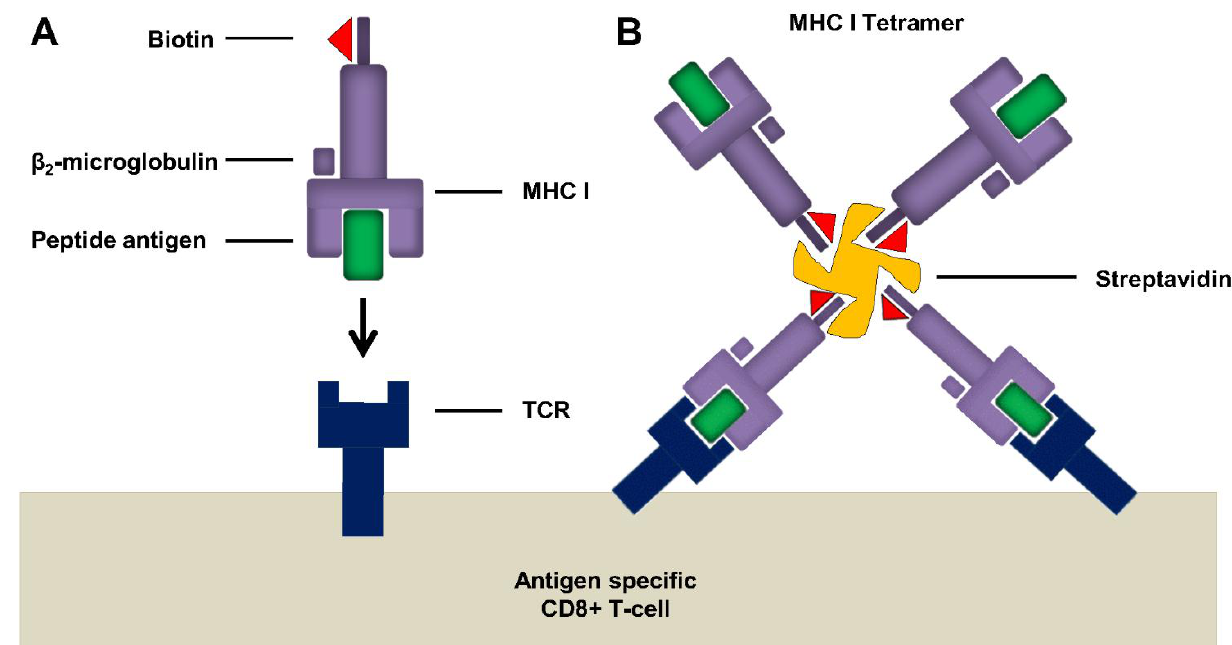
Figure 2. Tetramers increase avidity for epitope specific TCR interactions. ( A ) Schematic showing the recognition of peptide loaded biotinylated MHC I by Ag-specific TCR. Individual molecules have weak binding and cannot be stained; ( B ) Tetramerization of MHC I subunits is achieved by addition of fluorescently labelled streptavidin which interacts with